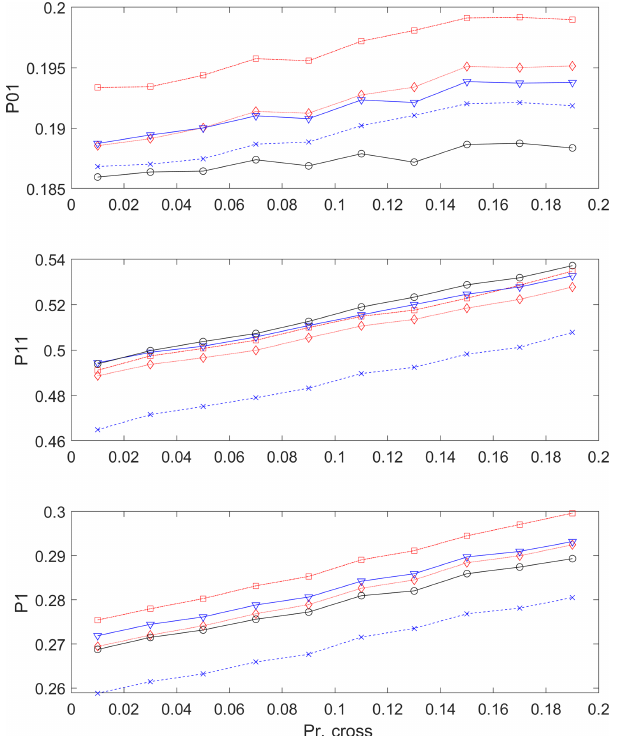
Figure 11. Transition probabilities and marginal distribution for the selected five stations along with changing the crossover probability P cr with the condition that the candidate value is 1 and the previous value is also 1. See Eq. (15) for